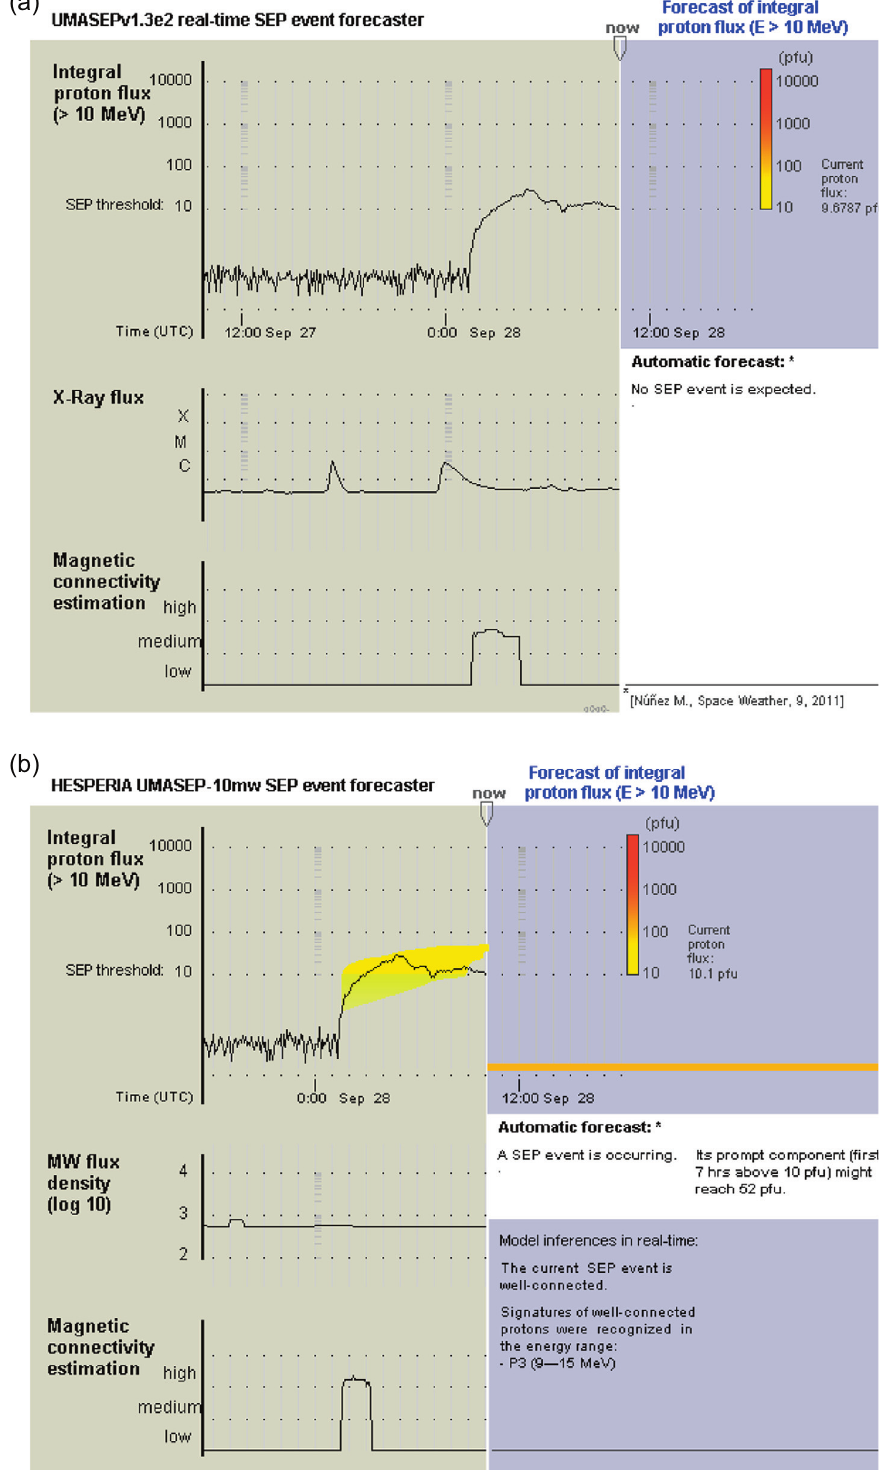
Fig. 8. UMASEP prediction web page for 2012 September 27: (a) and (b) show the SEP prediction using soft X-rays and microwaves,